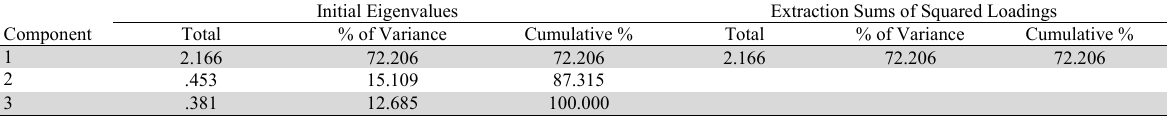
Initial Eigenvalues